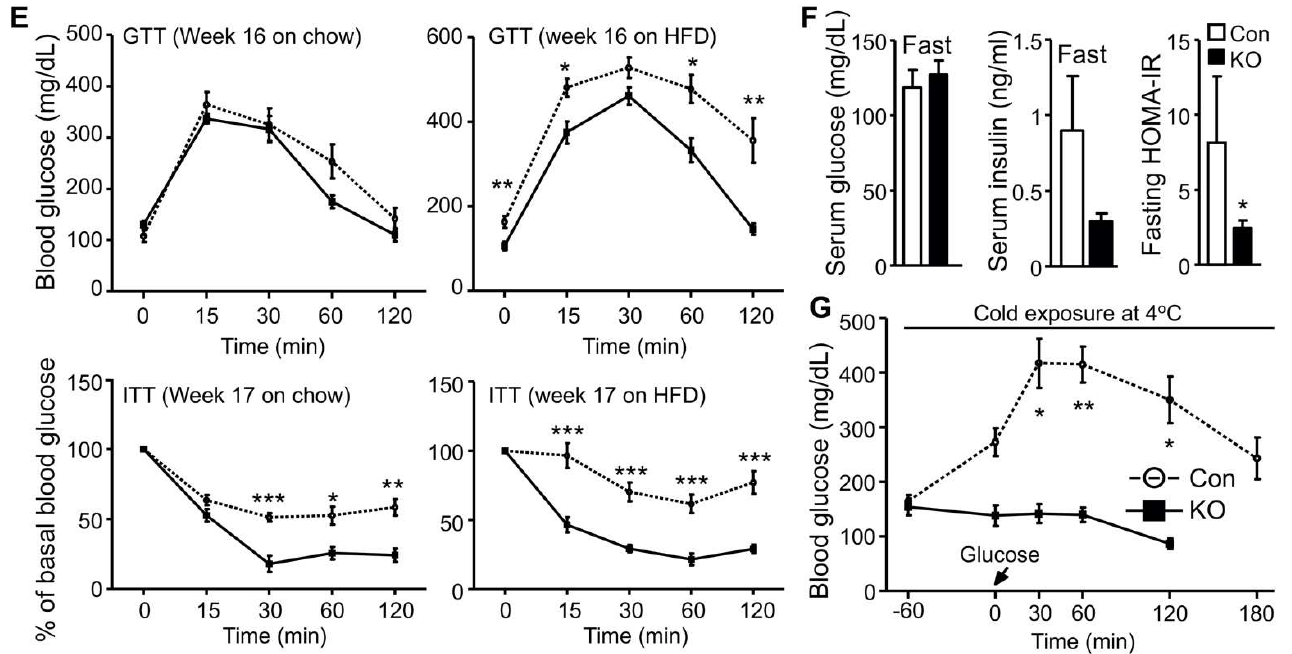
Figure 1. Deletion of adipose CGI-58 reduces serum FFA concentrations and increases whole-body glucose utilization. ( A ) Ex vivo lipolysis of iWAT explants from 14-week-old chow-fed mice ( n = 5/group). Glycerol concentrations in the medium of cultured iWAT explants were measured after a 2 h incubation at 37 °C in the absence (Basal) or presence of isoproterenol (Iso). ( B , C ) Serum concentrations of FFAs in the 15-week-old HFD-fed mice in the fed state ( B ) and in the 17-week-old HFD-fed mice after overnight fasting ( C ) ( n = 5–6/group). ( D ) The respiratory exchange ratio (RER) and the total energy expenditure (TEE) in 23-week-old FAT-KO and control mice fed the HFD ad libitum at room temperature and during cold exposure. The RER and TEE shown represent the data continuously collected for 3 h immediately before and 1 h after the switch of the housing temperature from 22 °C to 4 °C ( n = 4–6/group). ( E ) Insulin and glucose tolerance tests in mice fed a chow diet ( n = 5–6/group) or HFD starting at six weeks of age ( n = 7–8/group) at room temperature. ( F ) Serum levels of insulin, glucose, and fasting homeostatic model assessment of insulin resistance (HOMA-IR) indexes in 17-week-old HFD-fed mice ( n = 5–6/group). ( G ) Blood glucose levels of 11-week-old HFD-fed mice during acute cold exposure ( n = 4–5/group). The mice were fasted for ~6 h during the daytime cycle and then exposed to 4 °C for 1 h prior to intraperitoneal injection of a bolus of glucose at 1.5 g/kg BW while remaining at 4 °C for the time indicated. * p < 0.05, ** p < 0.01, and *** p < 0.001 vs. genotype; # p < 0.05 vs. treatment; ## p < 0.001 vs. housing temperature by two-tailed unpaired Student’s t - test.